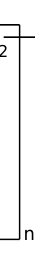
(DSC) calorimetry (DSC) measurements.